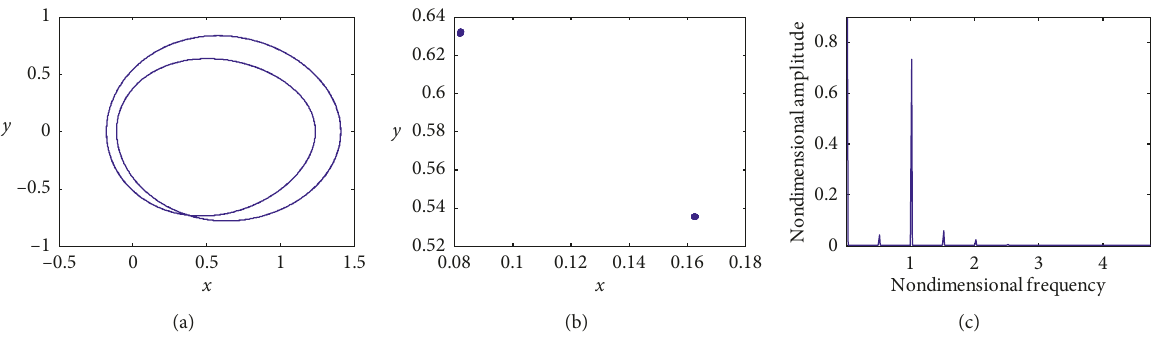
Figure 6: Dynamic response ( f � 0 . 1): (a) phase portrait; (b) Poincar´e map; (c) frequency spectrum. 2